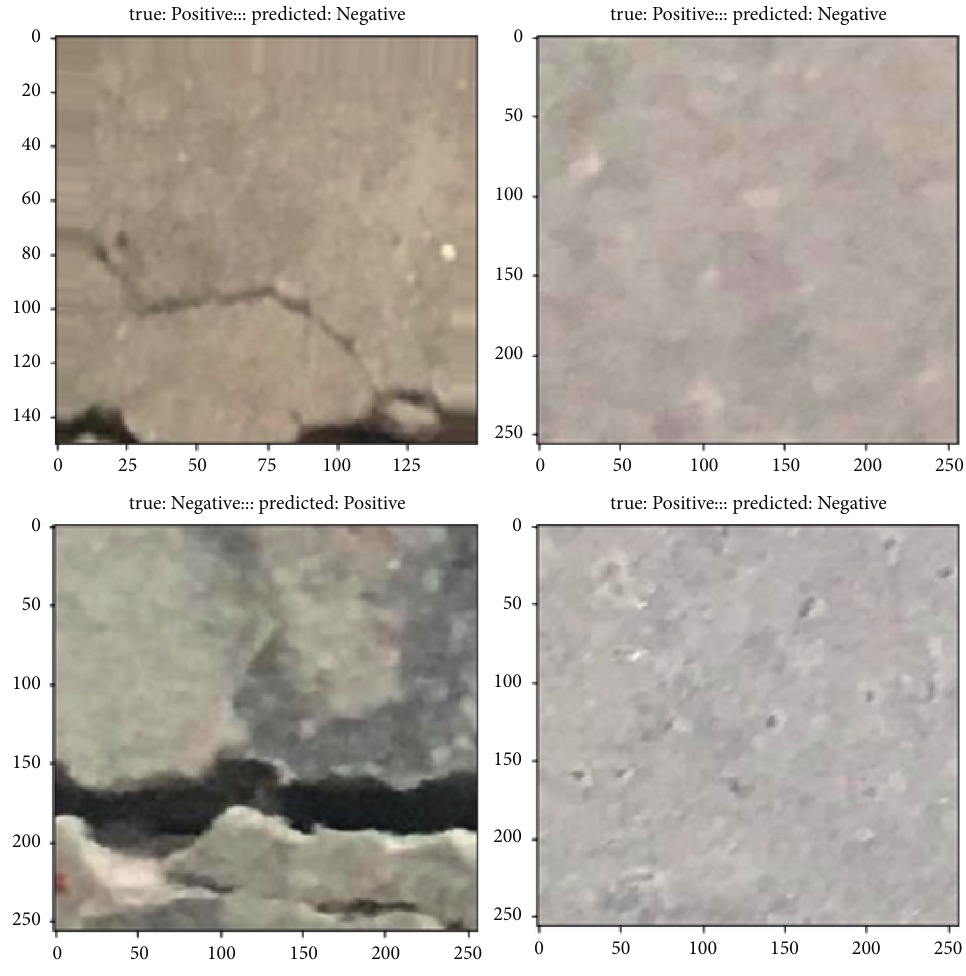
Figure 6: Wrong prediction of Model1 and Model2.